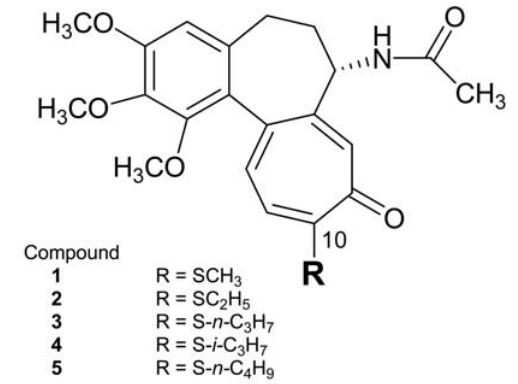
Fig. 1. Structures of 10-thioalkylcolchicine derivatives